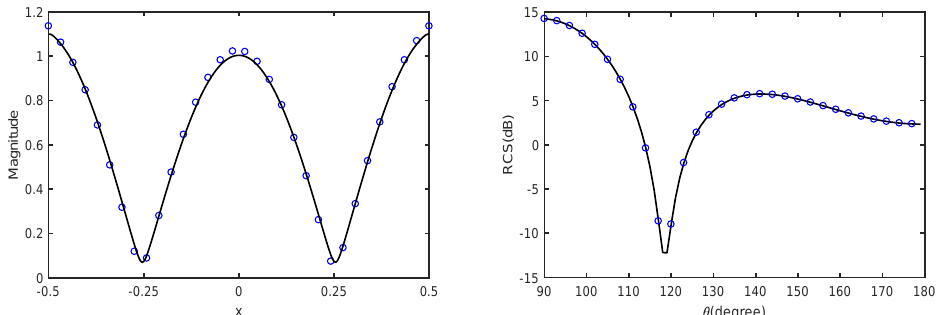
Figure 4. The magnitude of the aperture fields at normal incidence ( left ) and backscatter RCS ( right ) in TE polarization with k 0 = 2 π m − 1 , ε r = 1, h = 1/256 m, ‘o’: the solutions derived in [30], ‘-’: our